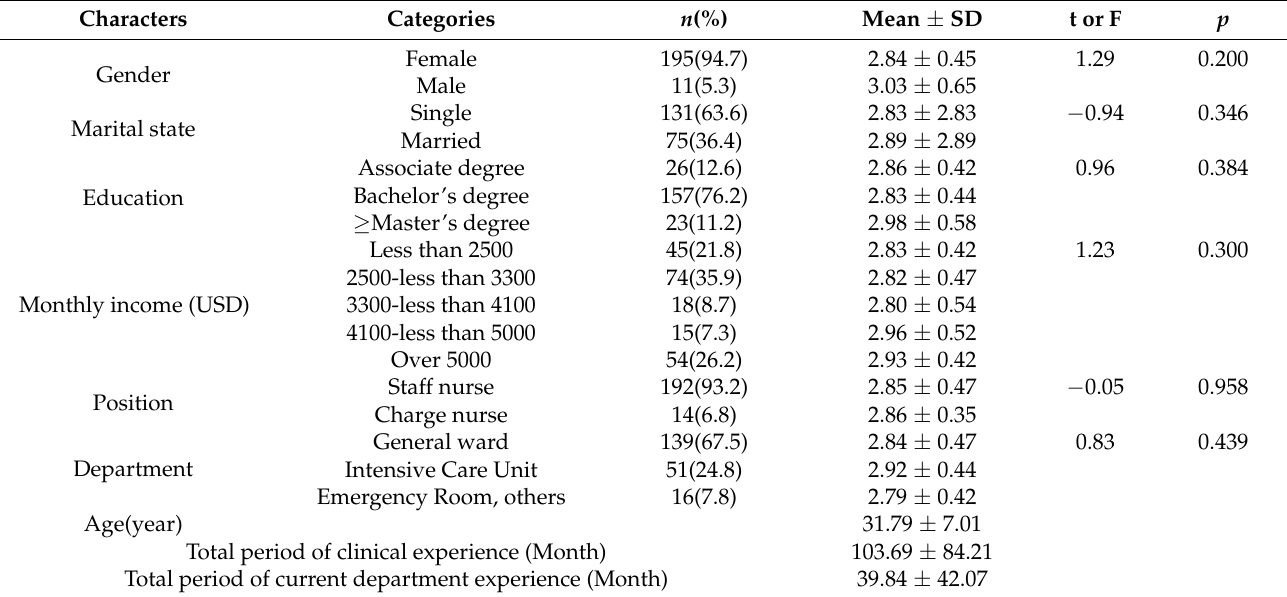
Table 1. General characteristics ( N =